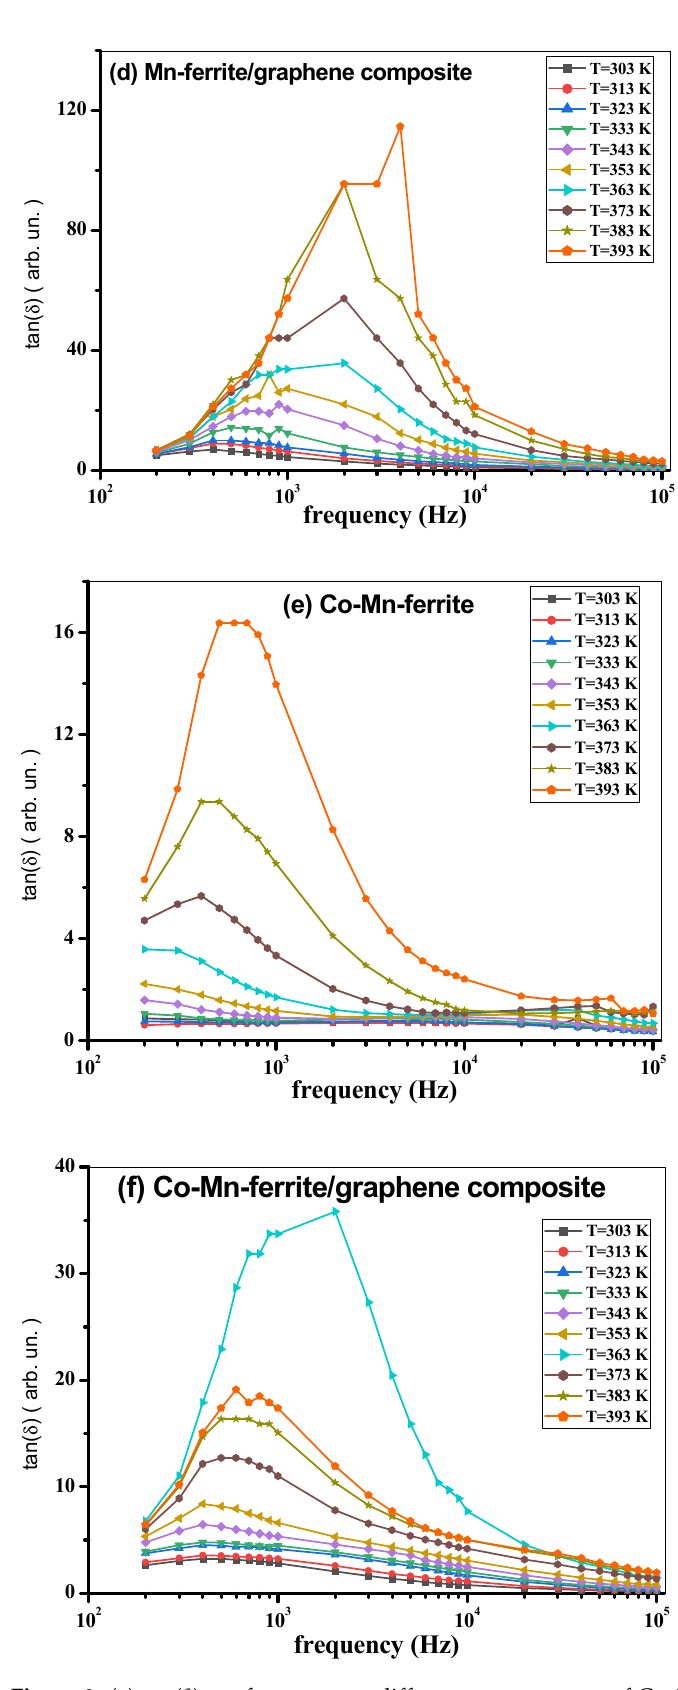
Figure 8. ( a ) tan( δ ) vs. frequency at different temperatures of Co-ferrite, ( b ) Co-ferrite/graphene, ( c ) Mn-ferrite, ( d ) Mn-ferrite/graphene, ( e ) Co-Mn ferrite, and ( f ) Co-Mn ferrite/graphene